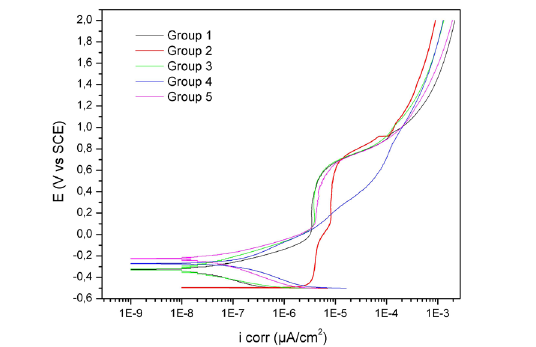
Figure 2. Potentiodynamic polarization curves for Co-Cr alloy in commercial mouthwashes (Group 1) Co-Cr Fusayama’s saliva; (Group 2) Co-Cr Listerine® alcohol-containing; (Group 3) Co-Cr Listerine® alcohol-free; (Group 4) Co-Cr Plax® alcohol-containing (Group 5) CoCr Plax®